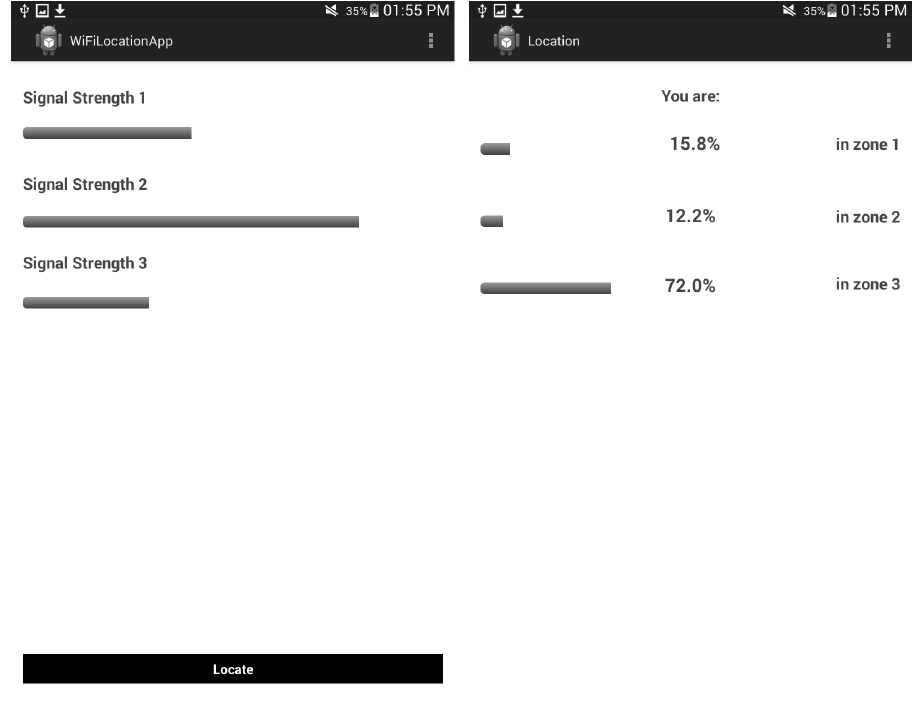
Figure 4. Demo of the Android application for indoor